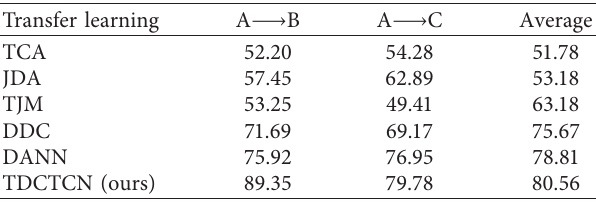
Table 2: Transfer accuracy for transfer tasks (%).